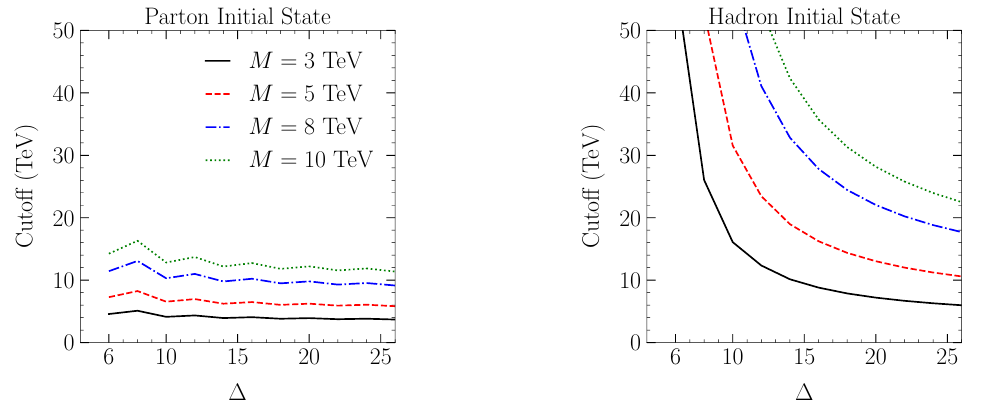
Figure 6 . The perturbative unitarity cutoff on E cm as a function of the EFT truncation dimen- sion ∆ for the t -channel model, derived using eq. (4.28). In the Partonic Initial State case [left], the perturbative unitarity cutoffs are more severe than for the Hadronic Initial State case [right], although the PDF effects do not fully remove the bounds.